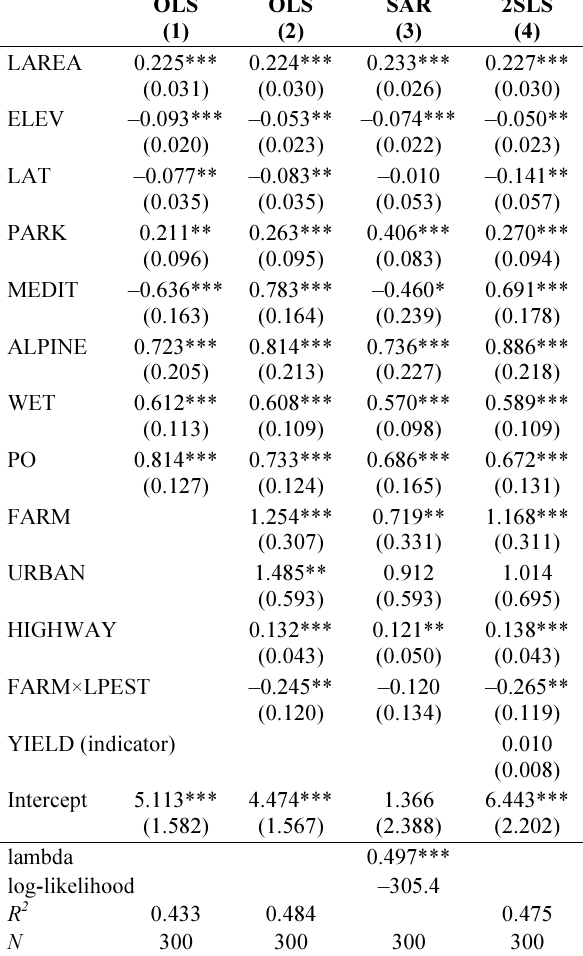
Table 3. Log bird species richness: estimates from